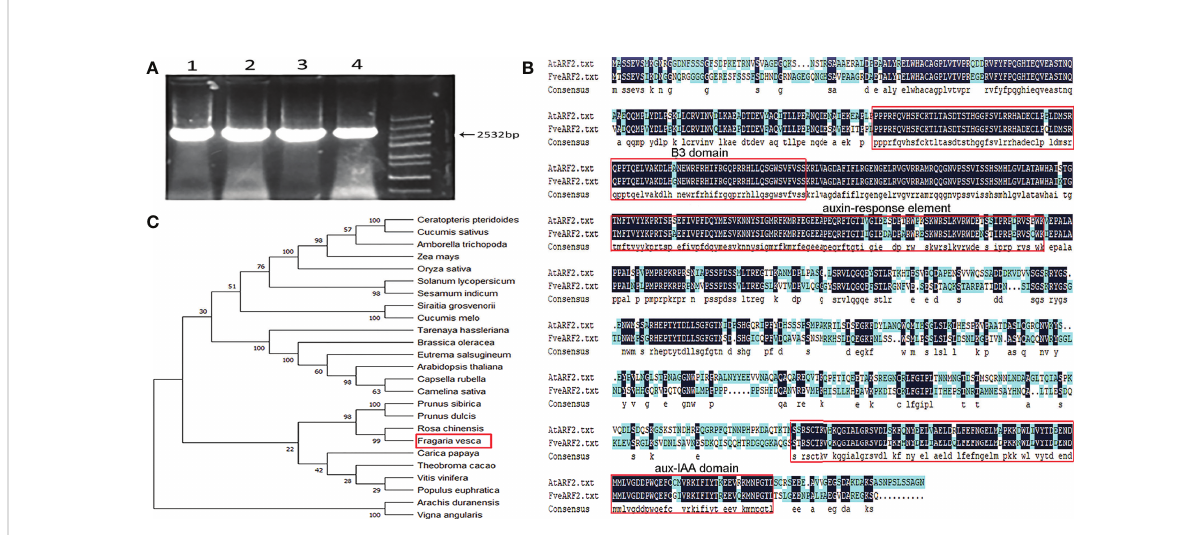
FIGURE 1 Ampli fi cation and structural and phylogenetic analysis of FveARF2. (A) Gene fragment ampli fi cation of the FveARF2 CDS. Strips of 1-4 lines represent the FveARF2 CDS region, which is 2532 bp in length. Marker: 5000 bp. (B) Structural and functional alignments of the FveARF2 and AtARF2 amino acid sequences. (C) Phylogenetic tree constructed from amino acid sequence alignments of ARF